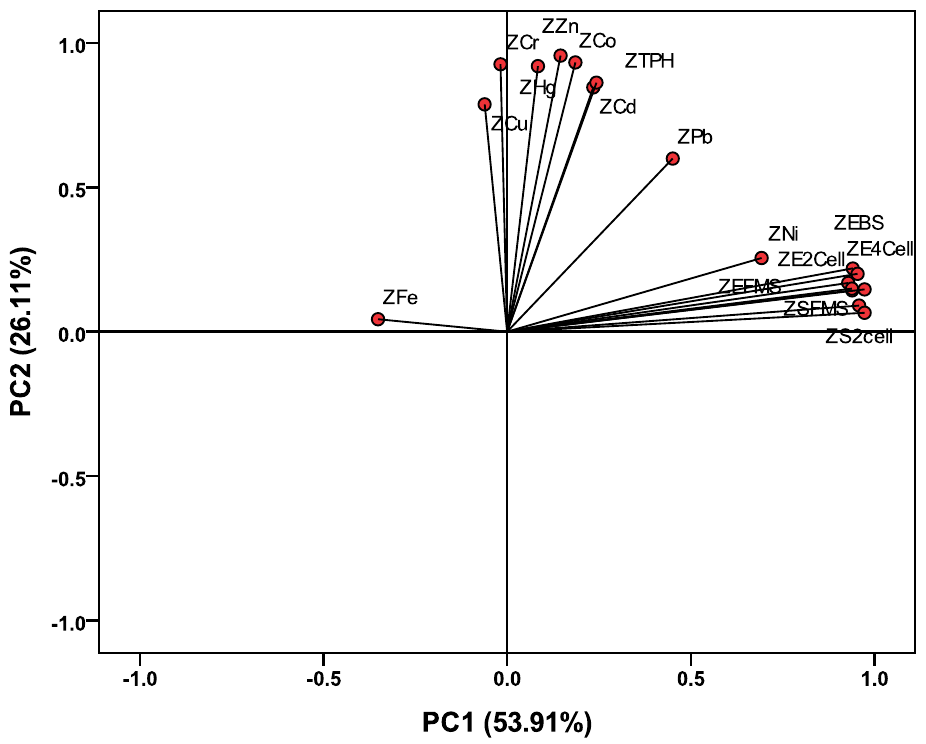
Figure 4. Scatter plot of (A) contaminants, bioassay, and ordinates along with the first two principal components of the different bioassay values for the southeast coastal regions of India .